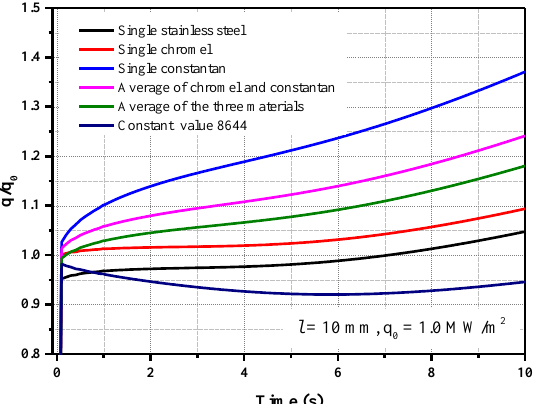
Figure 11. E ff ect of using di ff erent values of the thermal e ff usivity of the materials on the calculated Figure 11. Effect of using different values of the thermal effusivity of the materials on the calculated heat flux ( q 0 = 1.0 MW / m 2 heat flux ( q 0 = 1.0 MW/m 2 ).